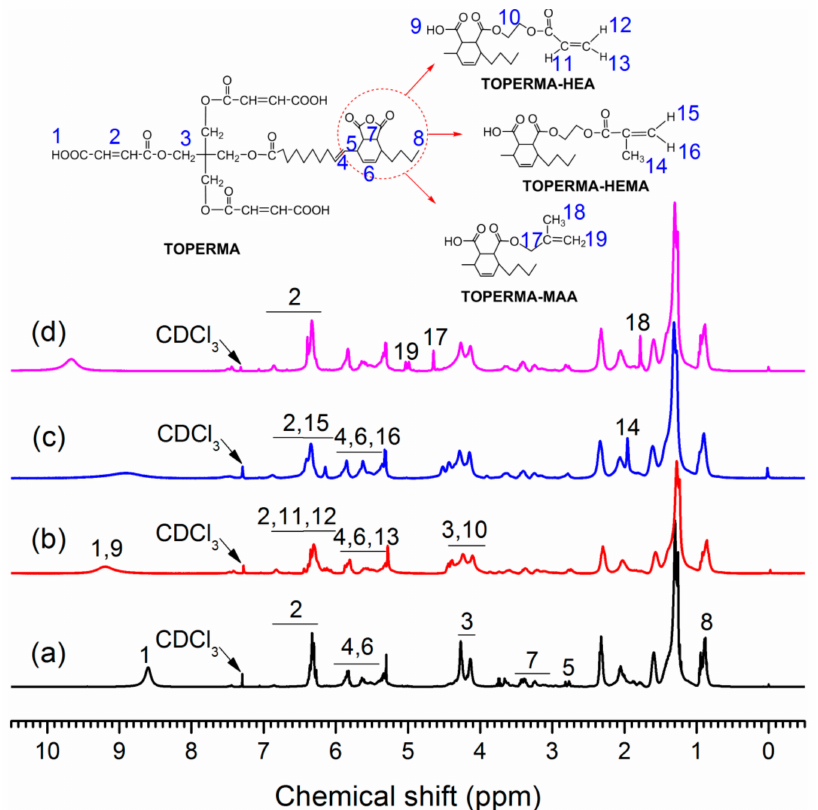
Figure 2. 1 H NMR spectra of ( a ) TOPERMA, ( b ) TOPERMA-HEA, ( c ) TOPERMA-HEMA, and ( d )